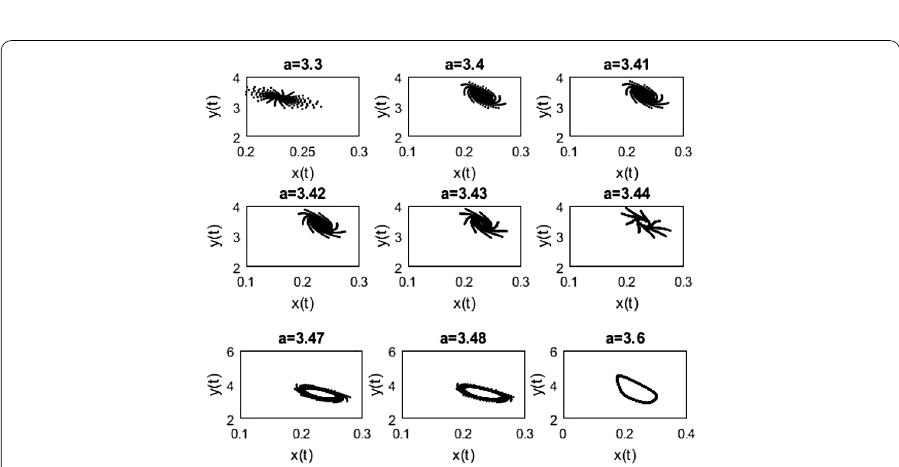
Figure 3 Phase portraits of the system (2) for different values of